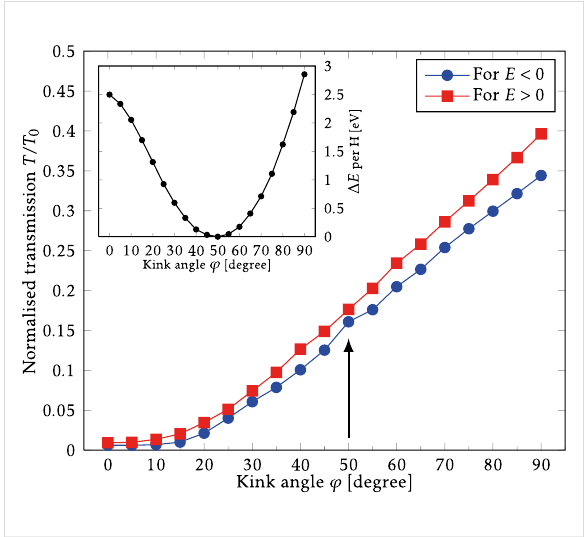
Figure 3: Electronic transmission through a single kink normalised by the transmission of pristine graphene ( T 0 ) as a function of the kink angle, φ , for electrons ( E > 0) and holes ( E < 0). The arrow indicates the normalised transmission at the equilibrium angle determined from the total energy calculations shown in the